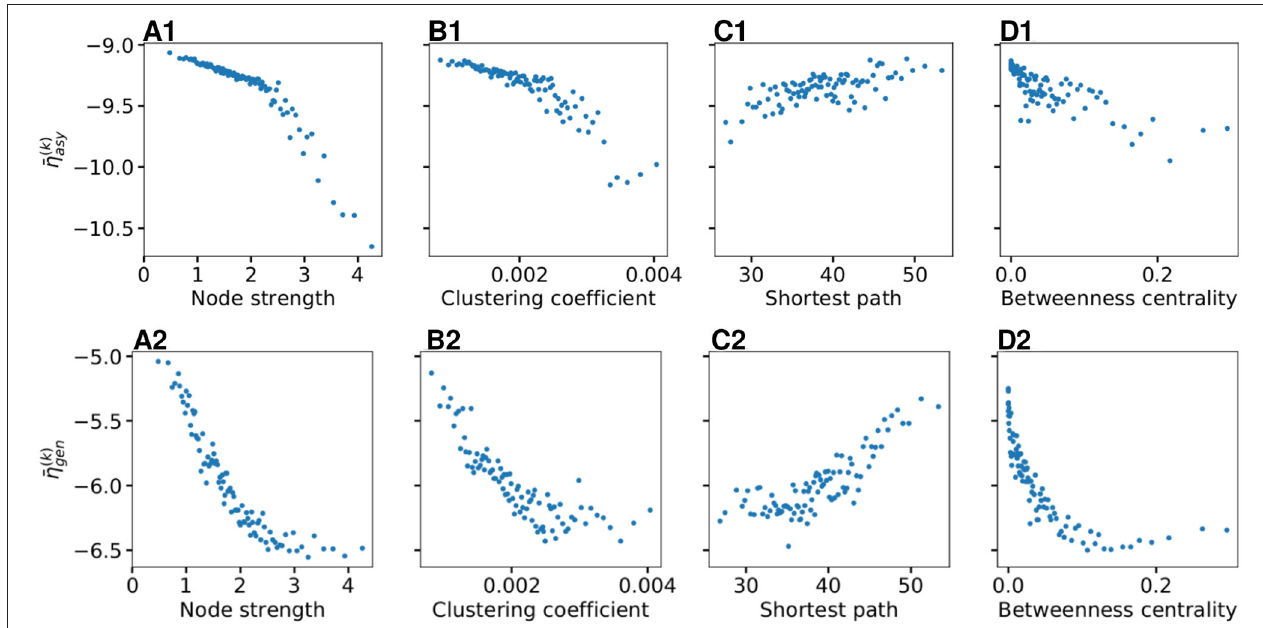
η ( k ) asy for asymptomatic seizure-like events (A1–D1) and FIGURE 5 | Thresholds ¯ Node strength, (B) clustering coefficient, (C) average shortest path length, and (D) betweenness centrality. For each panel, the thresholds all k [1,90] brain areas and averaged over all 20 subjects. Parameters as in Figure 3 ∈